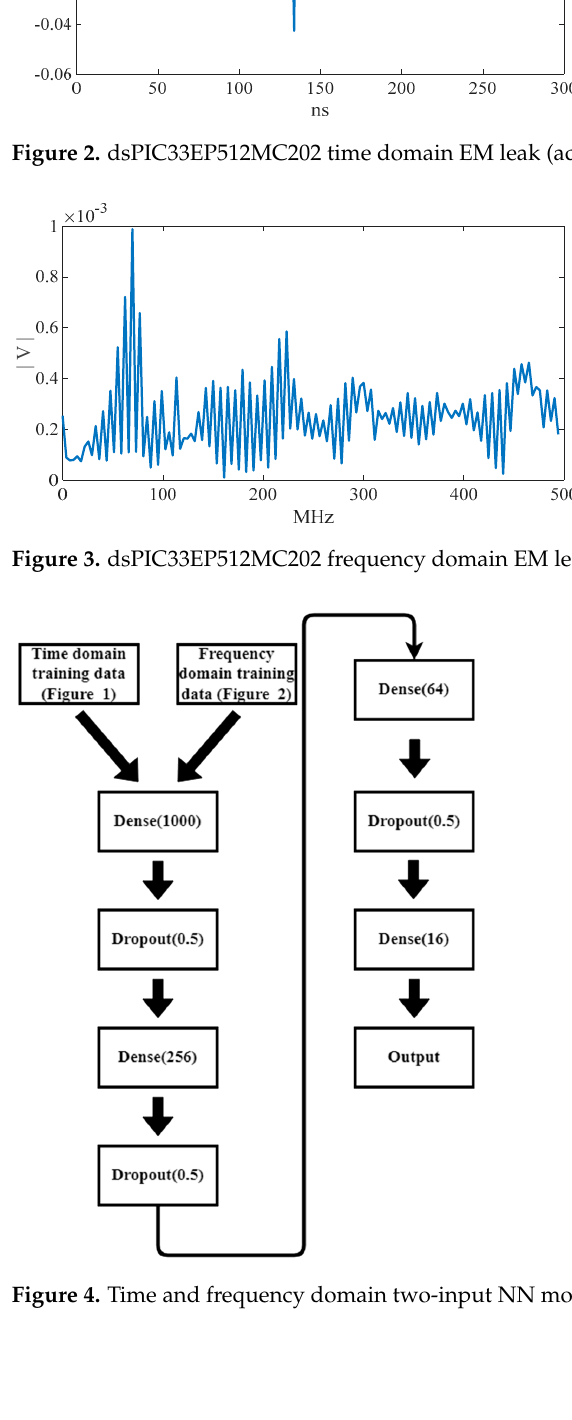
Figure 5. Training and validation accuracy of Figure 4 (adapted from [10]). 2.3. The Two Devices under Test (DUTs) 2.3.1. dsPIC MCU [18] One of the DUT targets is an MCU (microchip dsPIC33EP512MC202). It is a two ‐ stage pipeline MCU. The printed circuit board (PCB) is designed by the authors. Figure 6 shows the appearance of the MCU. The test program is designed by an assembly program and is programmed (burnt) using the MPLAB X IDE tool. The test assembly program mainly executes 18 target instructions following a fixed time delay and loops back indefinitely. The EMR signal fragmentation is cooperated by a system clock signal and an IOMark [14]. The IOMark will be briefly described below. A cc u r ac y